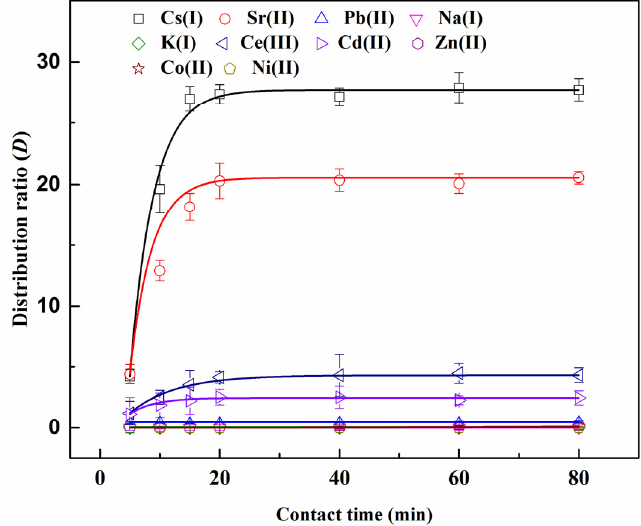
Figure 2. Dependence of the distribution ratio ( D ) of the tested elements onto SC4A with the change in contact time. Conditions: T = 298 K, [SC4A] (o) = 1 × 10 − 3 M, [Metal] (a) = 1 × 10 − 4 M, pH = 6 ± 0.05, shaking speed: 150 rpm.